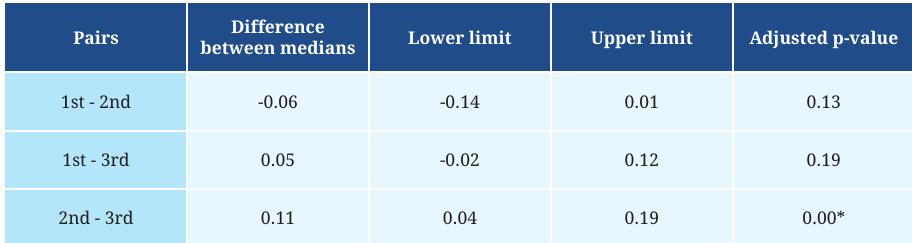
TABLE 3 | Results of pairwise PERMDISP for stream orders during the flood period. Data refers to the diet of Hyphessobrycon heterorhabdus sampled in eight streams in a protected area in the Eastern Amazon. *significant values at α <